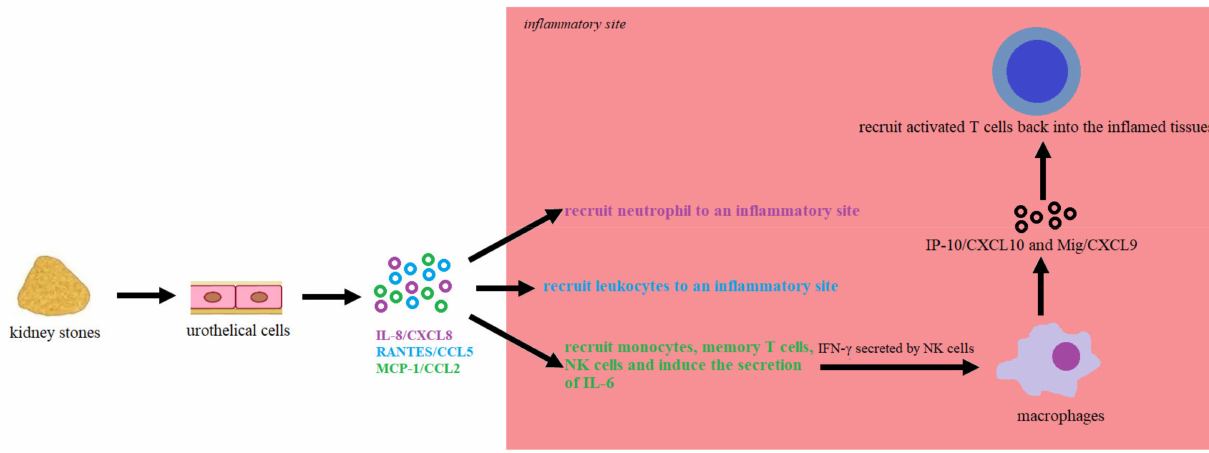
Figure 2. Initiation of “chemokine to cytokine to chemokine” cascade. Kidney stones may contain appreciable amounts of endotoxin, and can stimulate tubular epithelial to secrete chemokines, including IL-8/CXCL8, RANTES/CCL5 and MCP-1/CCL2, via TLR4. IL-8/CXCL8 plays a key role in the recruitment of neutrophils, while RANTES/CCL5 is known for leukocyte recruitment to an inflammatory site. In turn, MCP-1/CCL2 recruits monocytes, memory T cells, NK cells, and induces IL-6 and expresses intercellular adhesion molecule-1 secretion by tubular epithelial cells. Moreover, activated NK cells release IFN- γ , which can stimulate resident tissue cells to produce IP-10/CXCL10 and Mig/CXCL9, which are ultimately responsible for guiding activated T cells back into the inflamed tissues. Thus, stone-induced renal damage can initiate a “chemokine to cytokine to chemokine” cascade, which may play a crucial role in urolithiasis pathogenesis